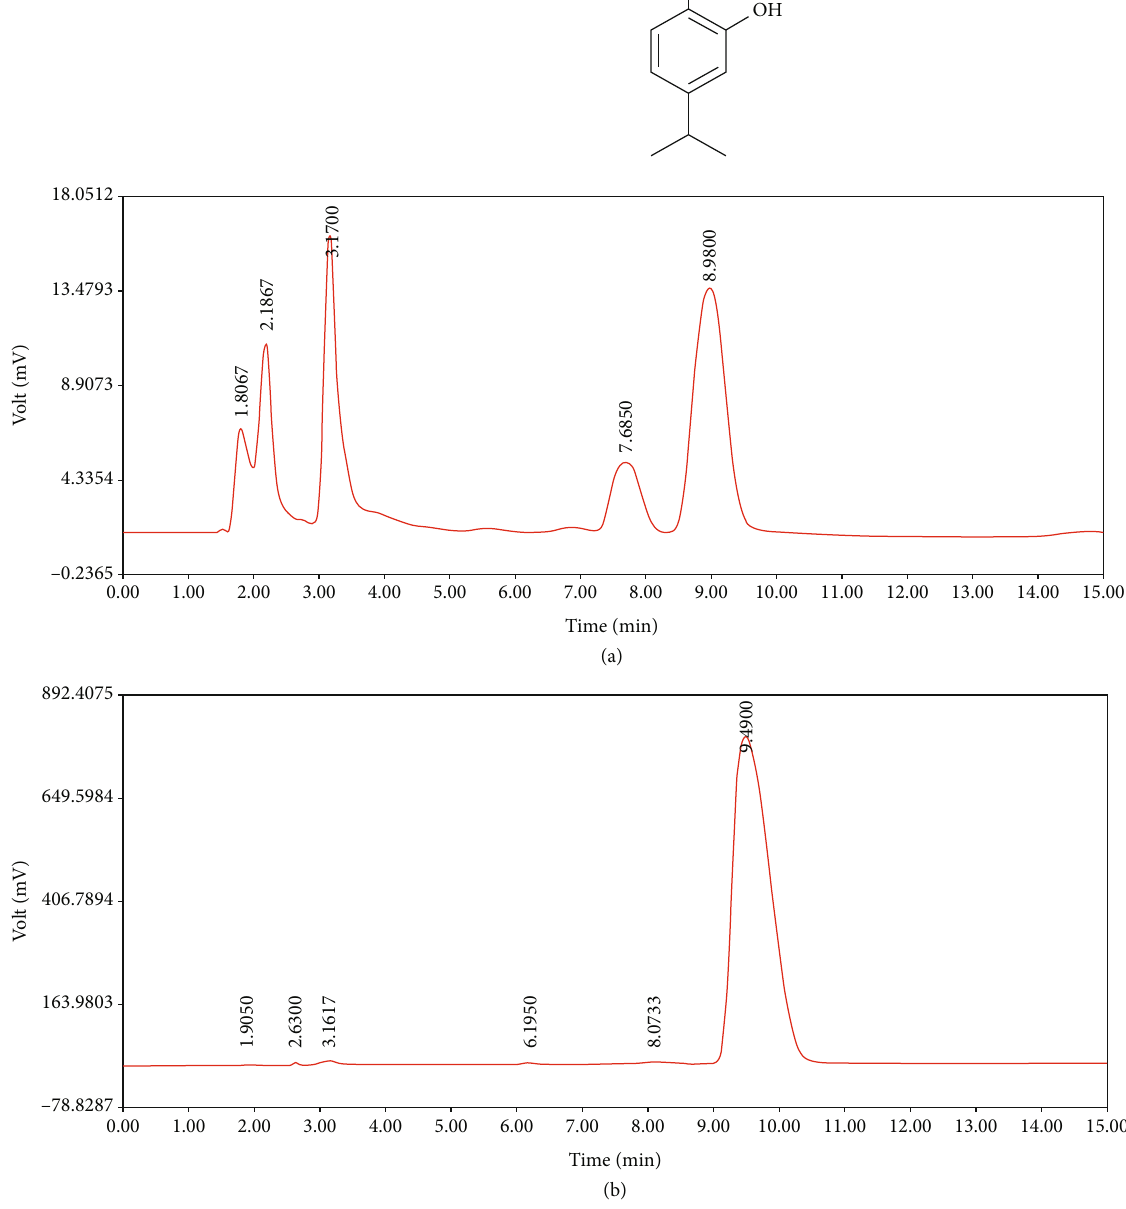
Figure 2: Fingerprint of (a) the extract of Z. multi fl ora (50 mg/mL) and the (b) pure carvacrol (C10H14O, 5/1000) (Boskabady et al., 2011). The extract showed a peak appears on 8.98min which was as the same as retention time (RT) of pure carvacrol